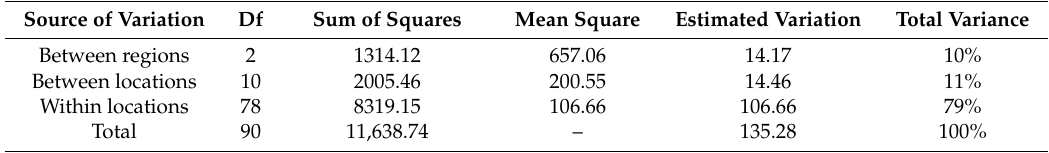
Table 5. Analysis of molecular variance (AMOVA) based on all 954 amplification products (AFLP, RAPD and ISSR) for 91 genotypes of S. purpurea ( p <